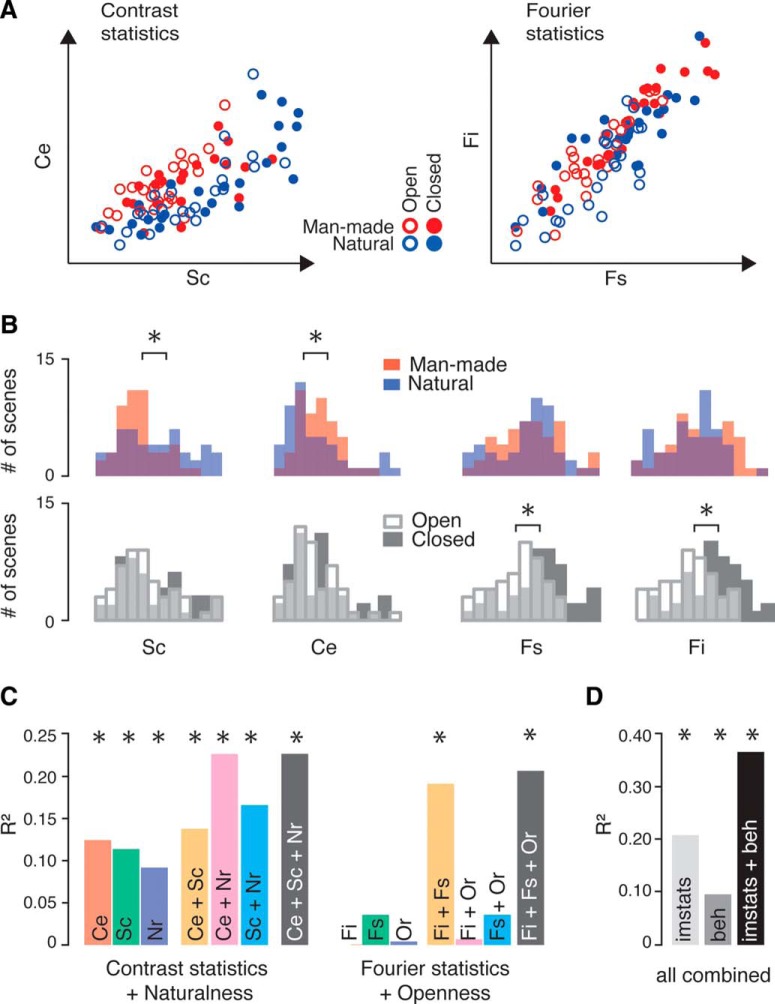
Image statistics analysis of the 96 scene stimuli used in Experiment 2. A, Local contrast statistics (left) CE and SC, and spatial frequency statistics (right) FI and FS (absolute values are plotted for clarity) for each of the 96 scenes, which are color coded by global categorical distinction. The local contrast and spatial frequency statistics describe two-dimensional spaces in which the scenes cluster by naturalness and spatial expanse, respectively. B, The distributions of man-made vs natural, and open vs closed scenes across the four different computational parameters. *p < 0.05. C, Explained variance (R
2) for a regression model consisting of combinations of local contrast statistics and behavioral naturalness ratings (Nr; left), and a model consisting of spatial frequency statistics and behavioral spatial expanse ratings (Or, right). D, Explained variance for a regression model consisting of all image statistics and all behavioral ratings. Note the change in y-axis compared with that in C.